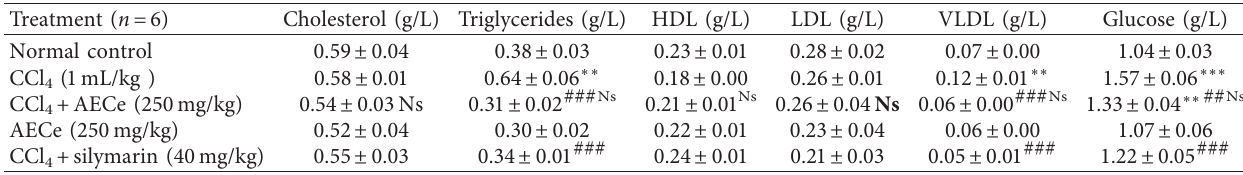
4 -induced lipid profile changes in rats.